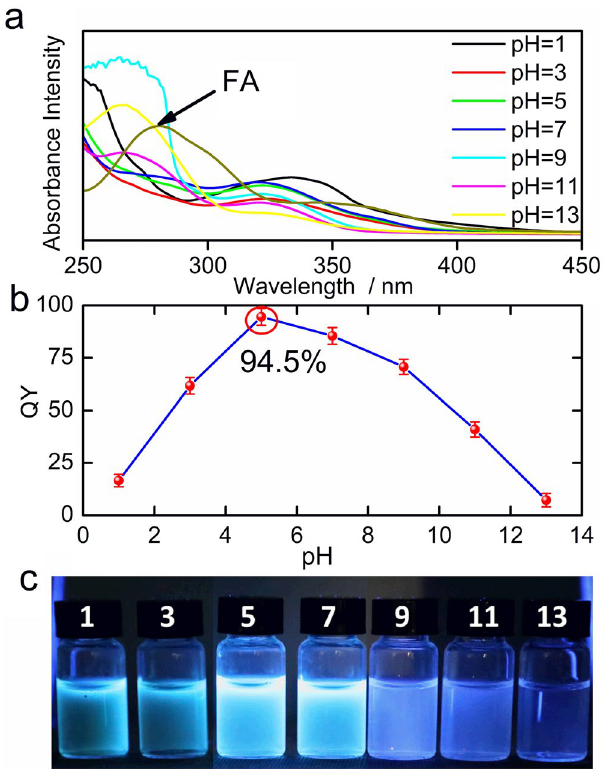
Figure 5. ( a ) Absorption spectra of the as-prepared CDs from FA under different pH. ( b ) Quantum yields of diverse carbon dots and ( c ) the corresponding